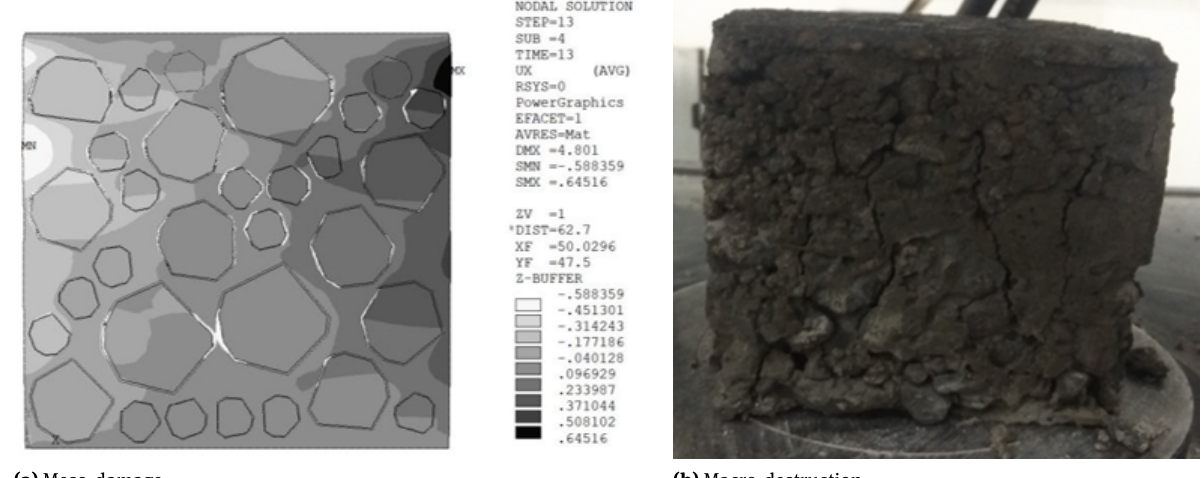
the stress peak became higher, and vice versa. It was be- cause that the elastic modulus of the aggregate and the ce- ment mortar was different, leading to inconsistent defor- mation, and if the grading was worse, the stress concen- tration was more obvious, resulting in lower strength of CSG overall. This result can provide guidance for the on- site